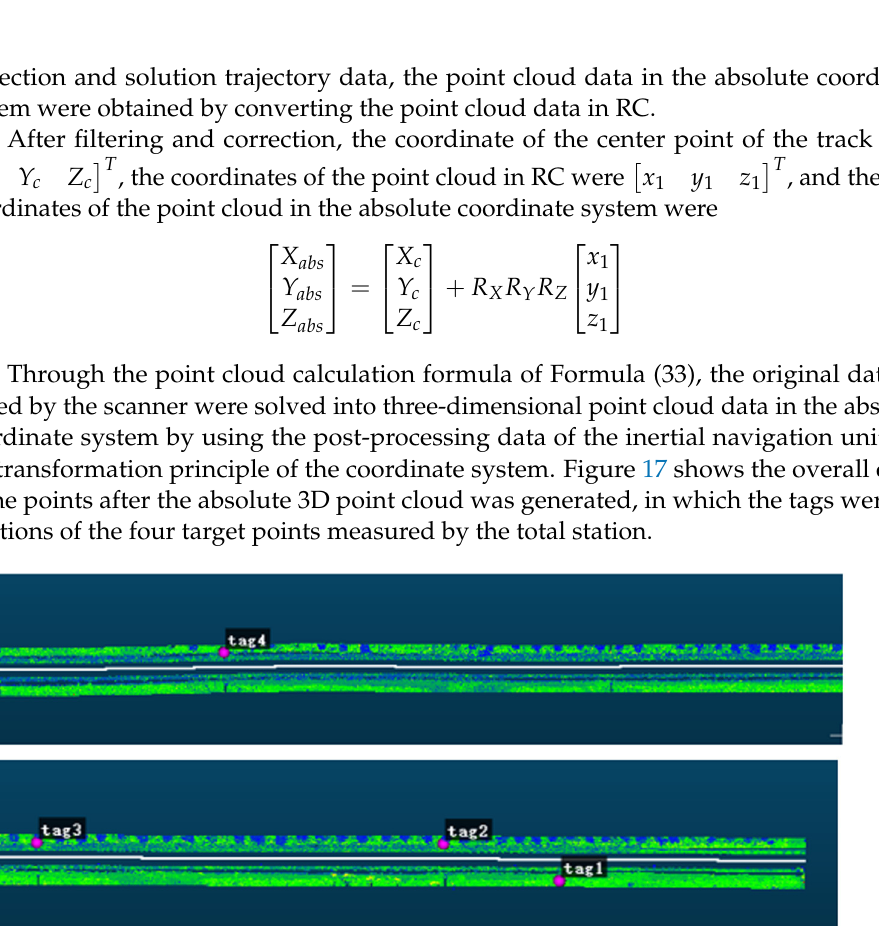
Figure 16. Recursive average filter effect.